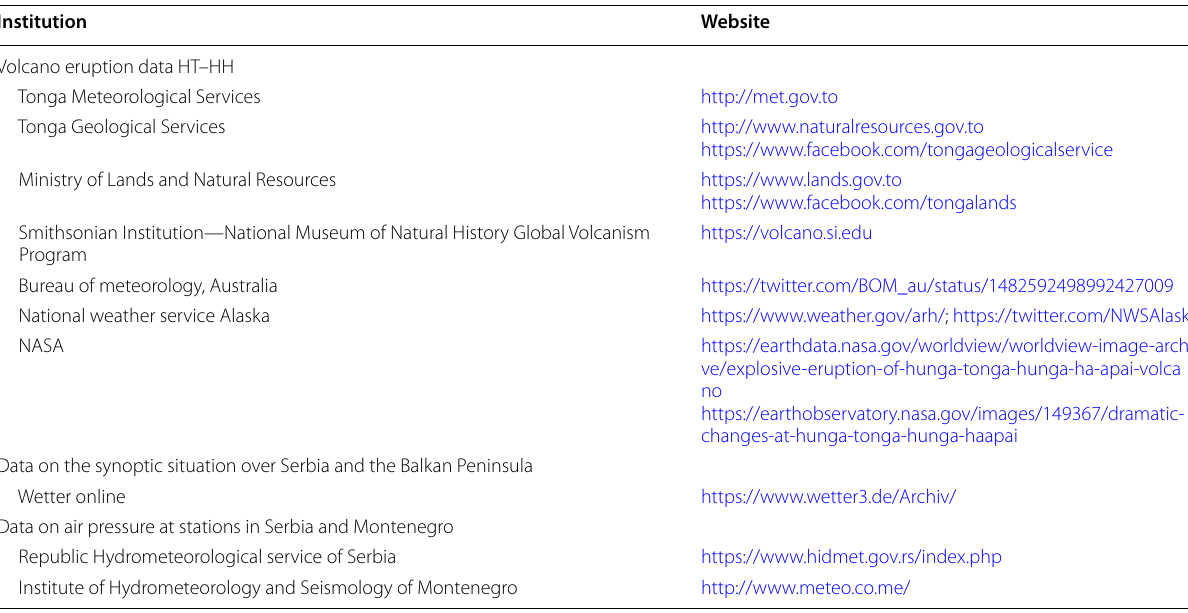
Table 1 List of institutions from which data were taken Institution Website